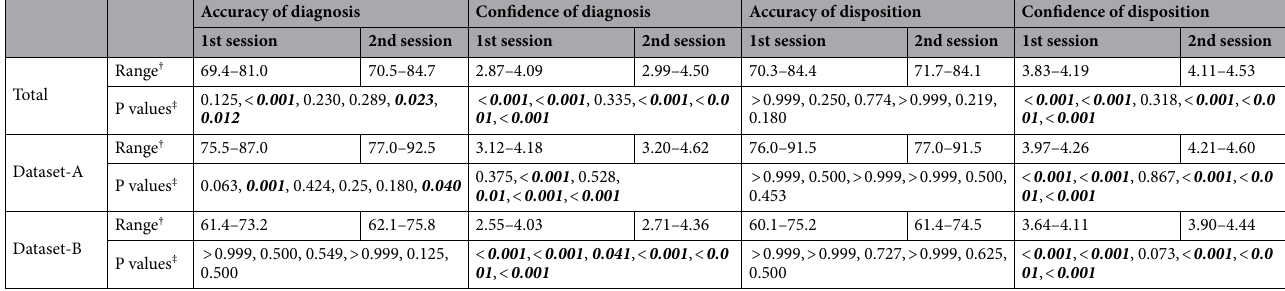
Table 1. Accuracy and Confidence of Diagnosis and Disposition decisions. † The range of accuracies (%) and arithmetic means of confidence (5-point scale) reported by six radiologists. ‡ Numbers are P values reported by each radiologist. McNemar’s test and Wilcoxon test were performed for each radiologist between 1st and 2nd sessions for comparison of accuracy and confidence, respectively. Bold italics indicate statistical